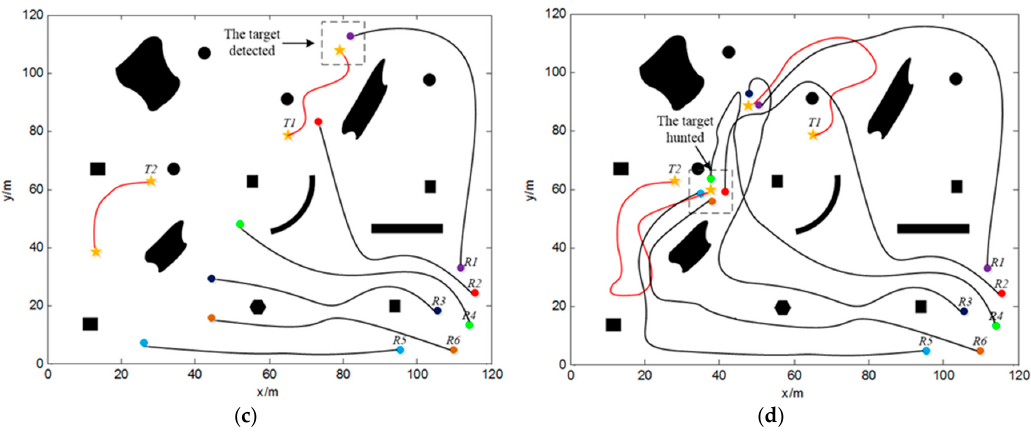
Figure 5. Simulation of hunting process with two targets. ( a ) The initial state; ( b ) AUVs’ hunting trajectory for the first target; ( c ) AUVs’ search trajectory for the first target; ( d ) Final trajectories of the AUVs.